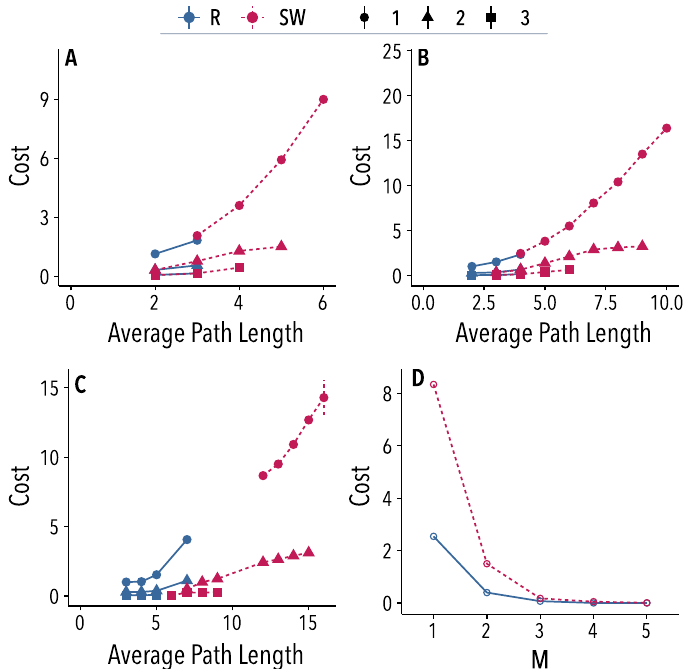
Figure 6. Numerical results of the model. ( A–C ) Average final cost (in 10 4 ) of the cheapest path after a period of 10 4 rounds as a function of the average path length of the network. Different panels correspond to different network sizes: 26 ( A ), 50 ( B ), and 1,000 ( C ) nodes; colors correspond to different network models: random (blue) and small-world (magenta); and different shapes correspond to different values of the number M of disjoint paths. For each configuration, there were generated 10,000 networks of size 26, 50, and 1,000, according to the Watts-Strogatz algorithm 24 with p = 0.1, 1 and average degree from 2 to 10. The initial cost was set to 0 and the increment/decrement ratio was fixed to the experimental value ( σ/ρ = 2.4 ). Results for M > 5 are not shown as costs converge fast to 0. D: Mean value of the cost of the cheapest path versus M for the same networks. See the main text for further details. Figure created using ggplot2 (v.3.2.1) 21